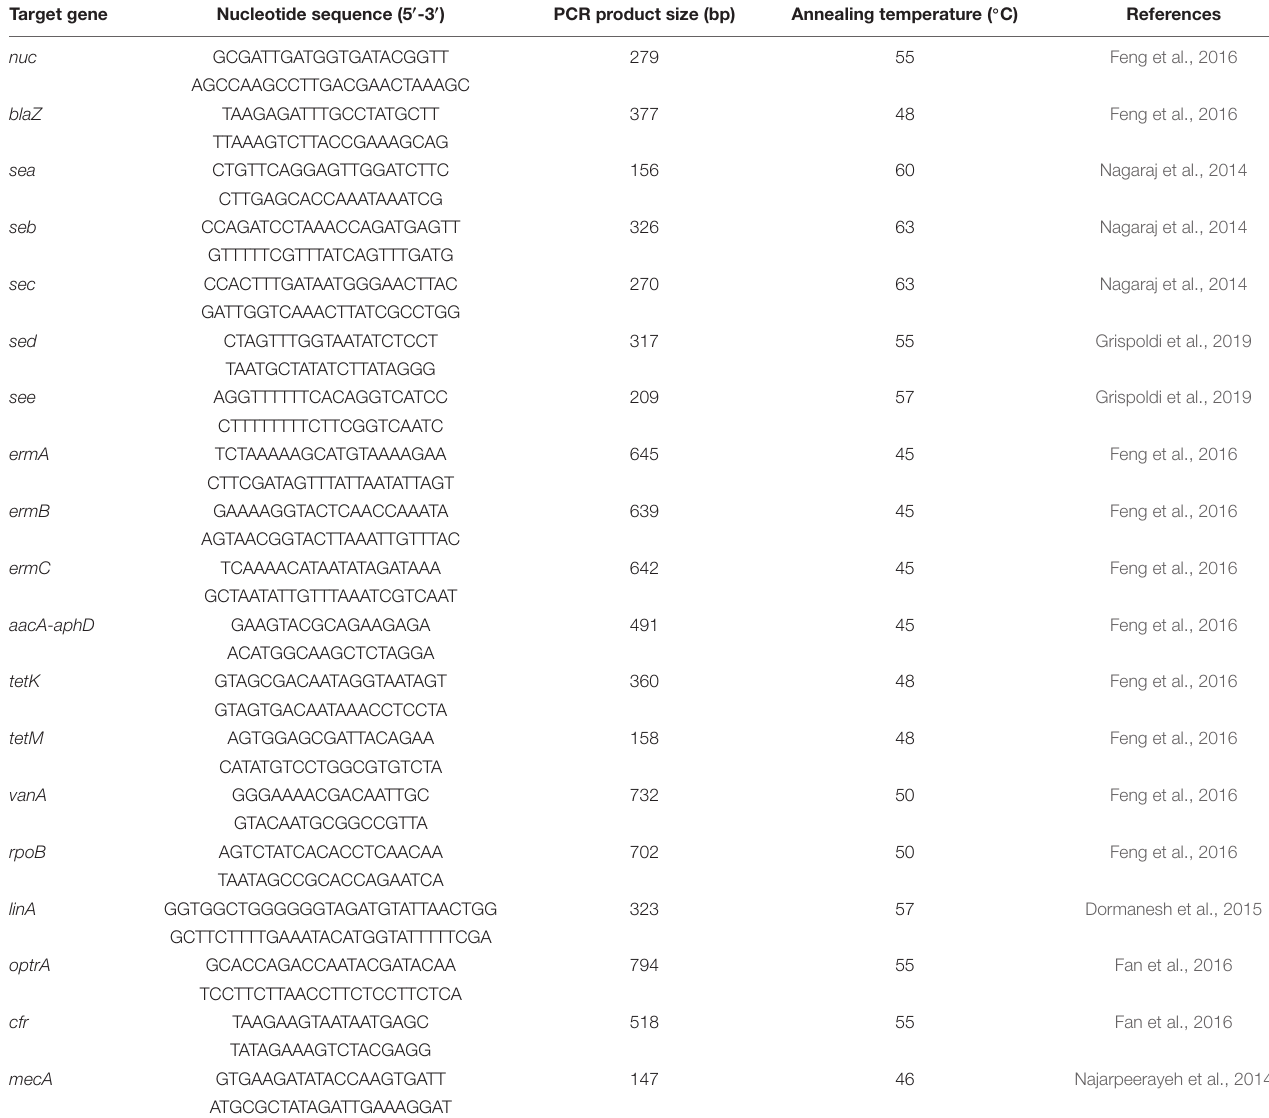
TABLE 1 | PCR primers for nuc , virulence, and antibiotic resistance genes. Target gene Nucleotide sequence (5 (cid:48) -3 (cid:48)